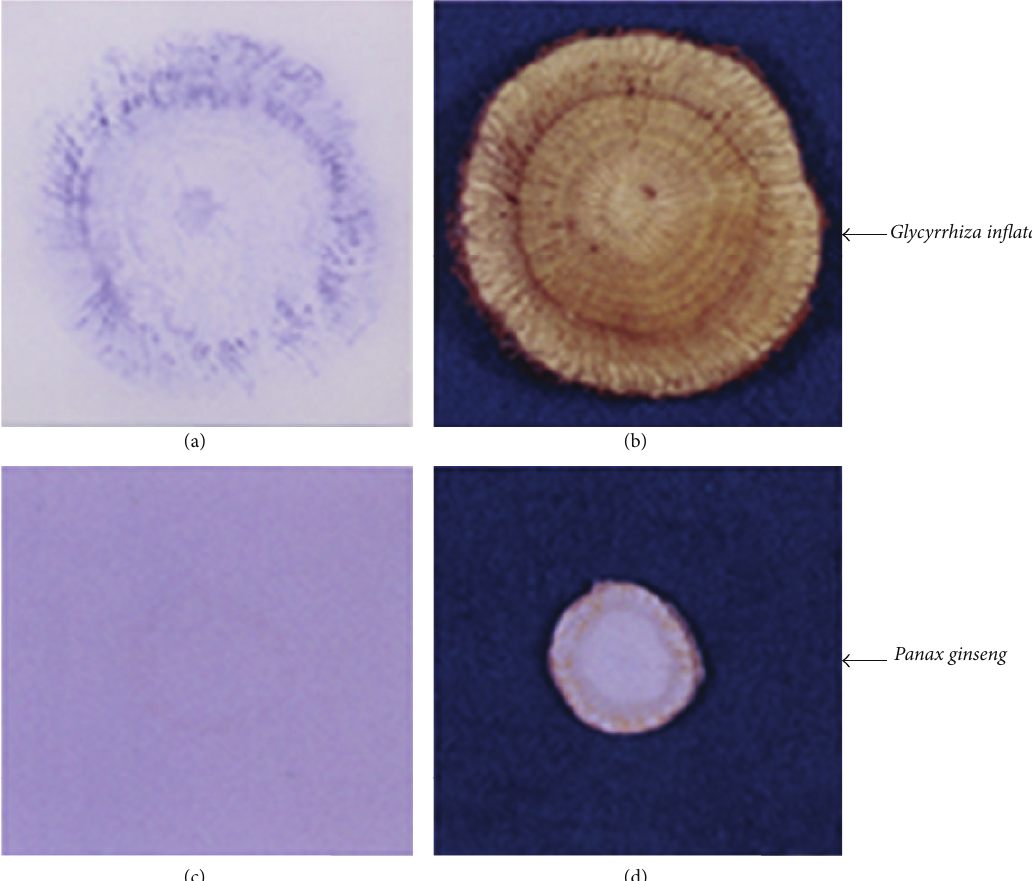
Figure 5: Direct eastern blotting of licorice slice using antiglycyrrhizin MAb. (a) Eastern blotting of licorice slice, (b) licorice slice, (c) eastern blotting of ginseng slice using antiglycyrrhizin MAb, and (d) slice of